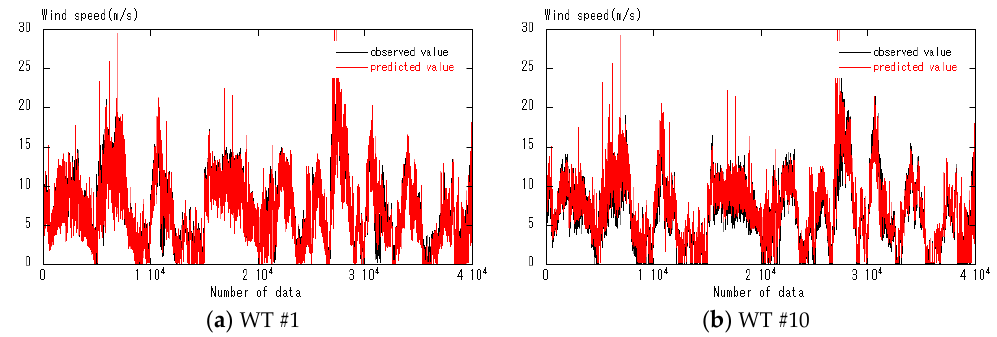
Figure 11. Time-series data of observed and predicted wind speed, reference point: WT #6.